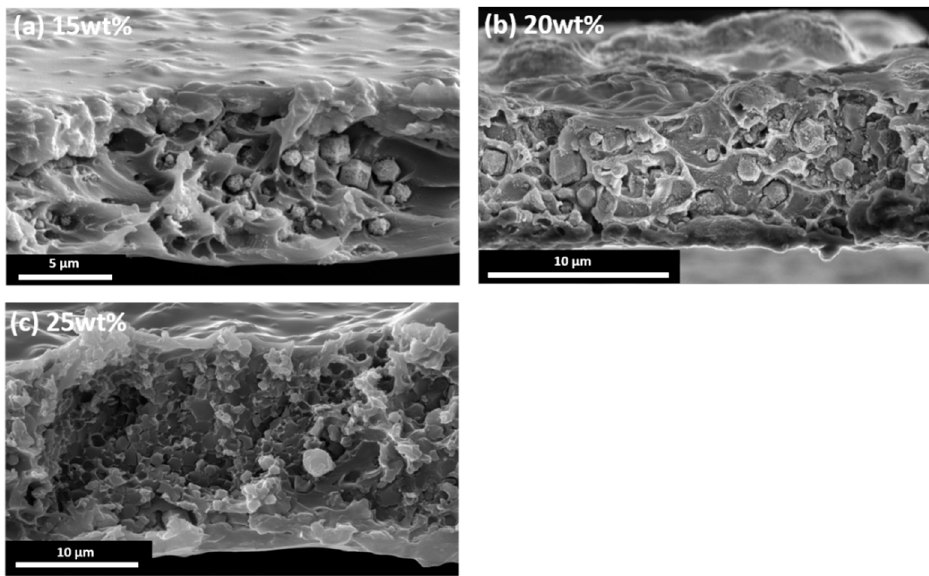
Figure 7. SEM cross-sectional image of the L-His-ZIF-8/Torlon ® MMM ( a ) 15 wt% L-His-ZIF-8, ( b )